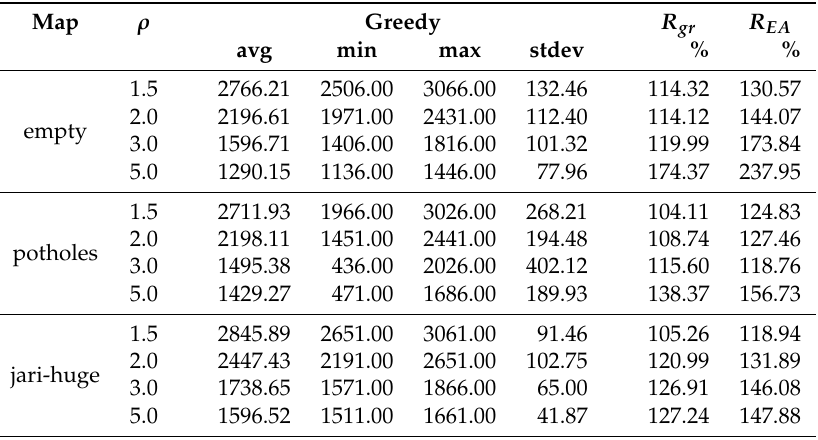
Table 2. Experimental results for UMARI